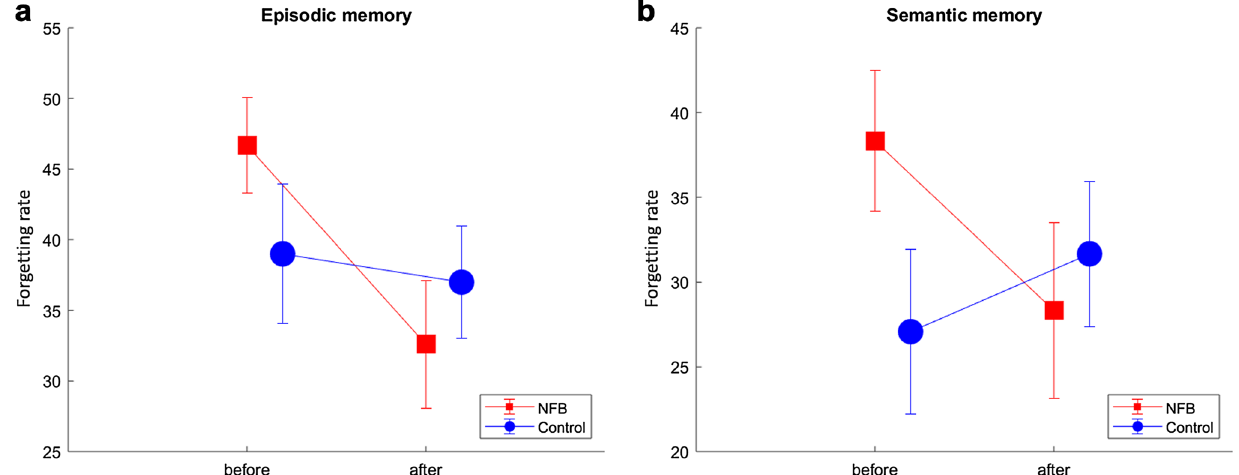
Figure 1. Forgetting rate for episodic and semantic memories. ( a ) The forgetting rates for episodic memory during the first (before) and third (after) stages are shown for both groups. ( b ) The forgetting rates for